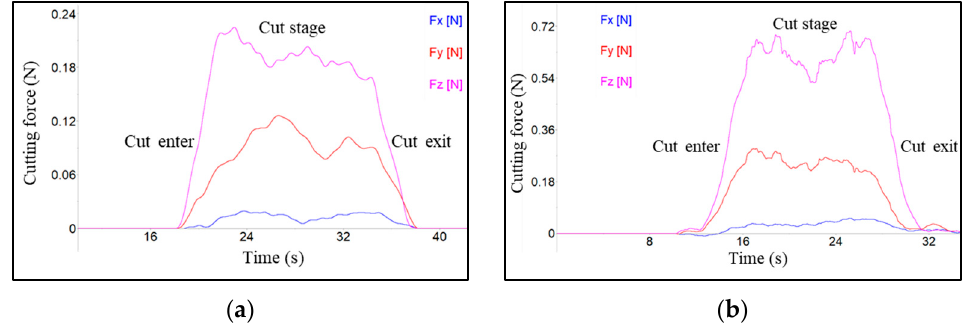
Figure 5. Cutting-force-signal comparison ( a p = 10 μ m, f r = 5.6 μ m/r, v = 6.4 m/s), ( a ) cutting-force- signal without magnetic field, ( b ) cutting-force-signal with magnetic field.